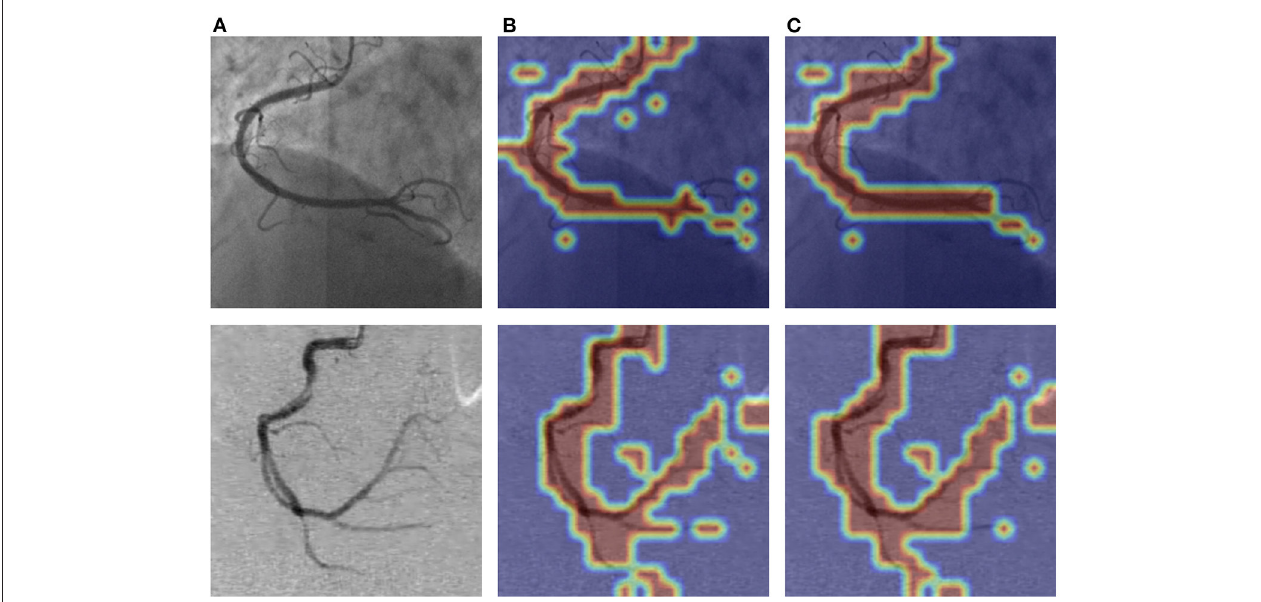
FIGURE 9 | The visualization of PAM of the attention layer our network learned. The images in (A) column are the original angiograms, the images in (B) are the heatmaps after the encoder module without PAM, and the image in (C) are the attention heatmaps with PAM. The higher the frequency of the vessel regions, the brighter the